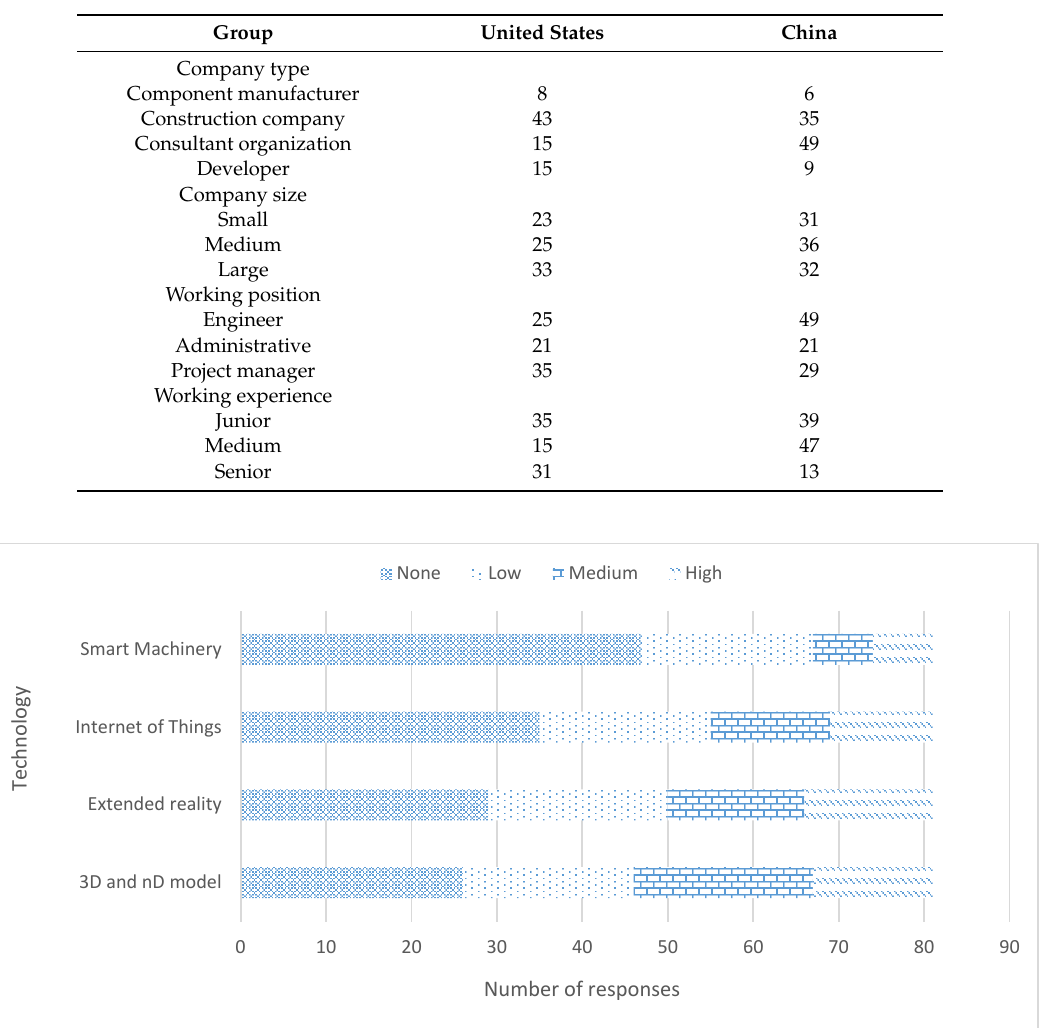
Table 2. Data distribution.